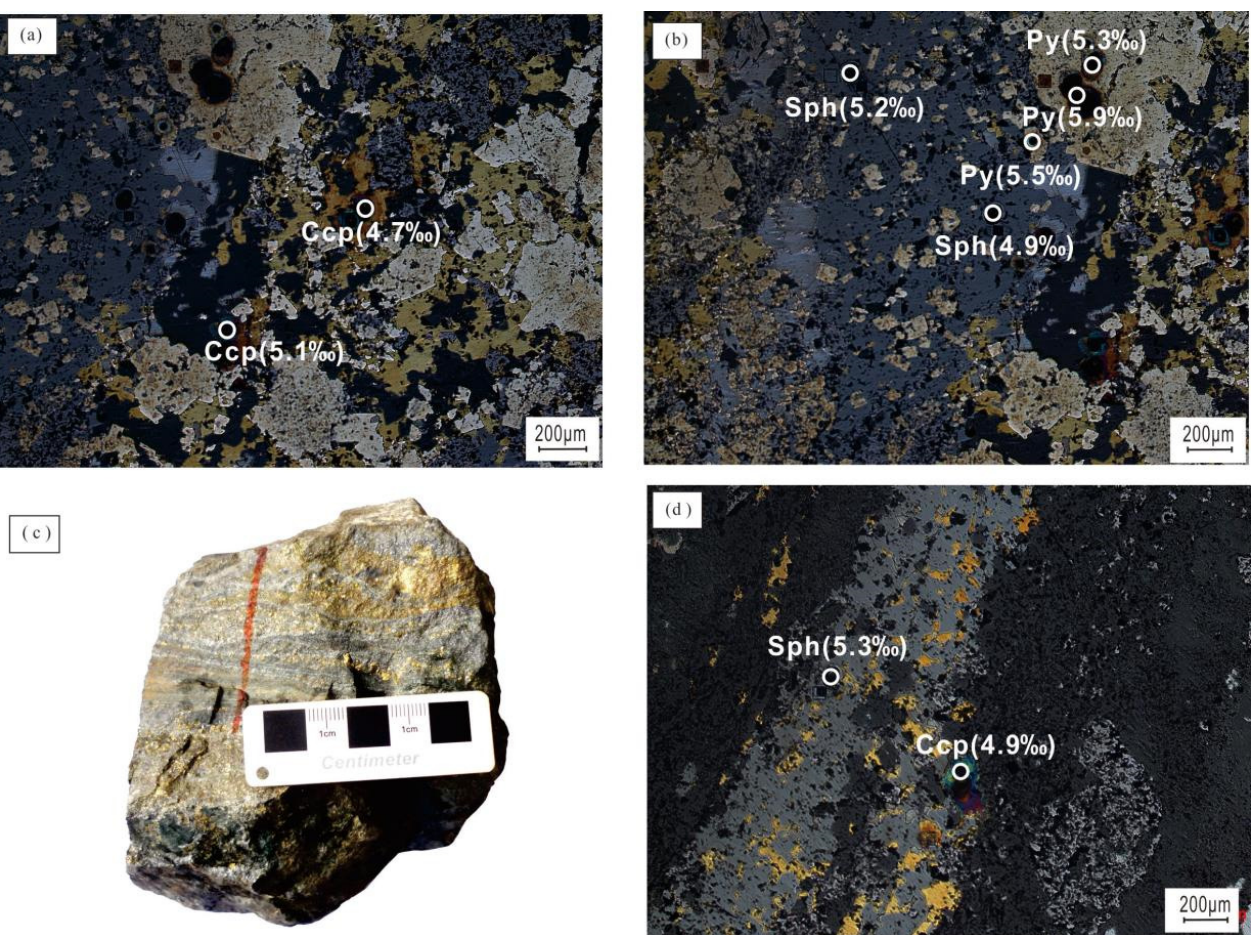
Figure 6. In situ S isotope analyses of the Caiyuanzi deposit. ( a , b , d ) Microscopic photos of metal sulfide and corresponding in situ sulfur isotope values; ( c ) in situ S isotope test specimen of sulfide ores.